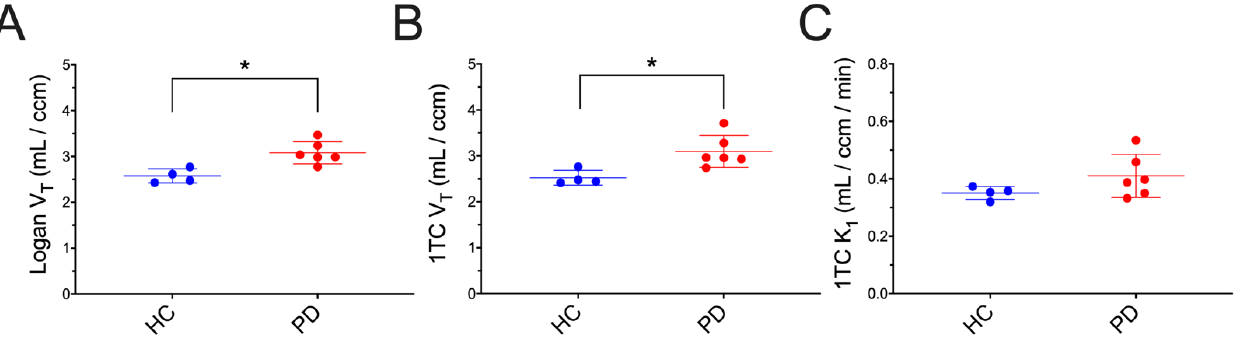
Figure 4. Whole-brain [ 18 F]NOS Logan V T ( A ), 1TC V T ( B ) and 1TC K 1 ( C ) comparisons between healthy and PD cohorts where an * denotes significant differences at p < 0.05.